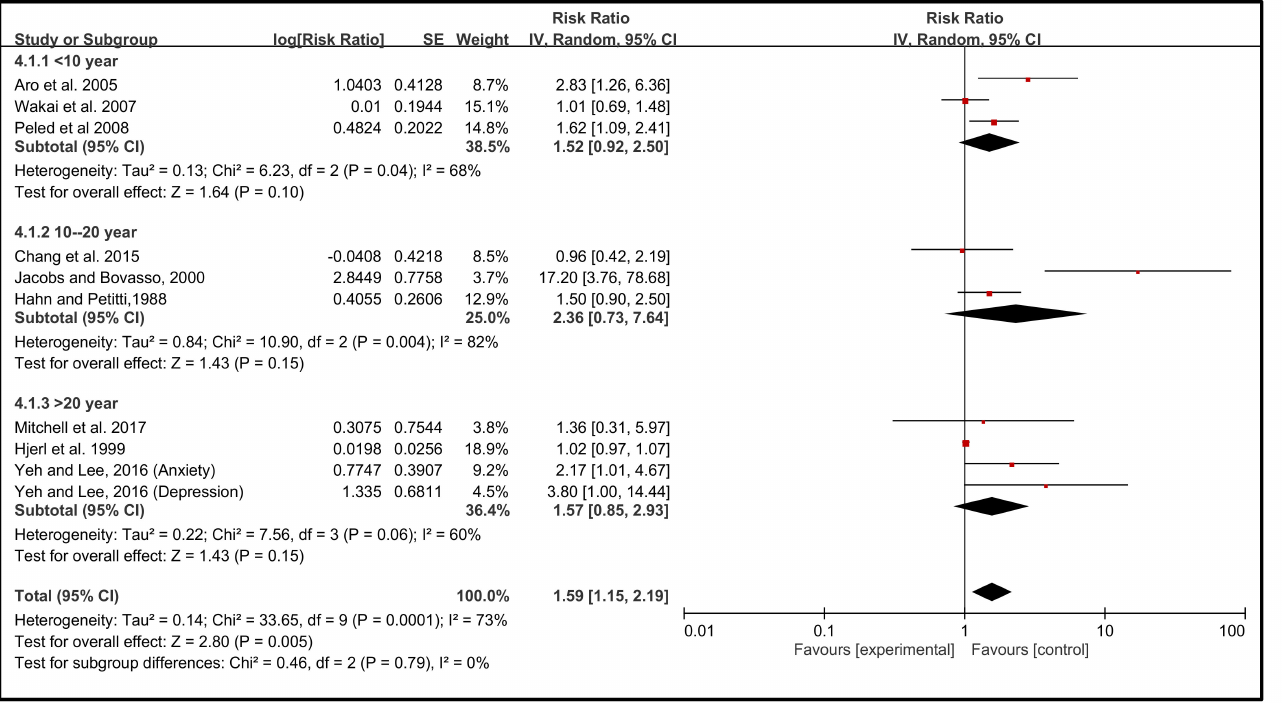
Figure 5. Follow-up years. The results were stratified by follow-up duration